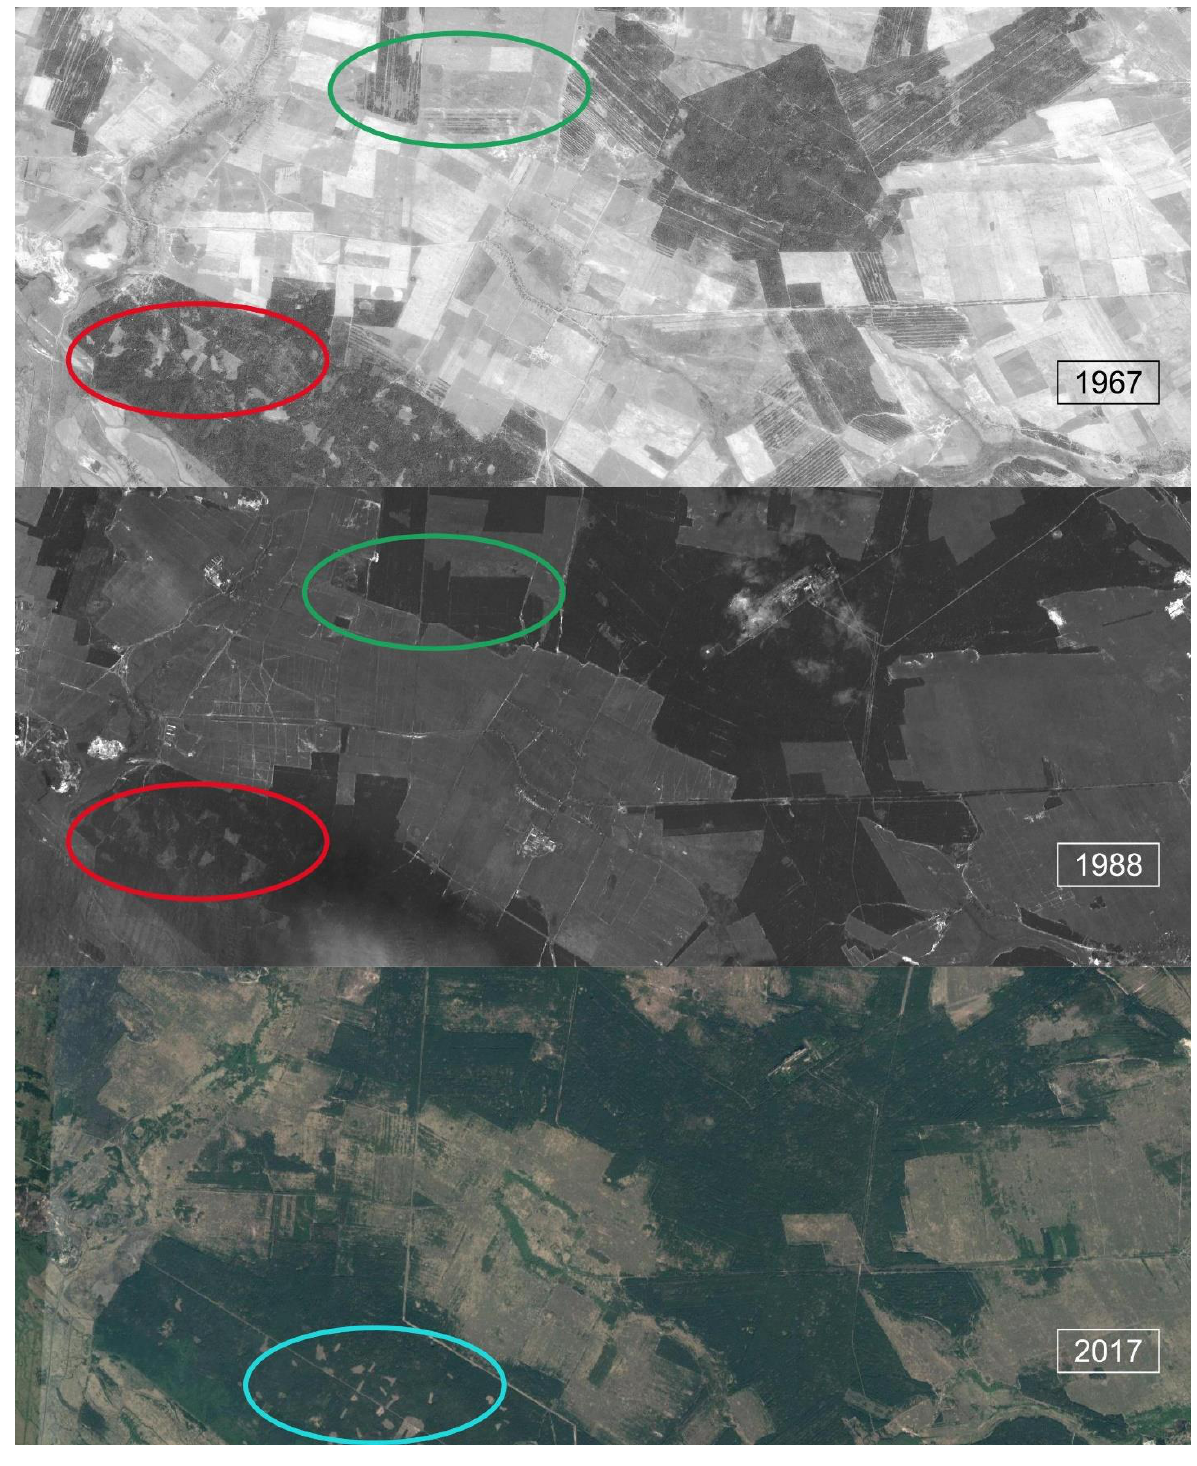
Figure 8. Change in forest cover within the test site in the central part of the ChEZ. The green circle refers to artificial forest planting, the red circle to regrown clear-cuts up to 1988 and the blue circle refers to new clear-cuts that have appeared up until 2017.